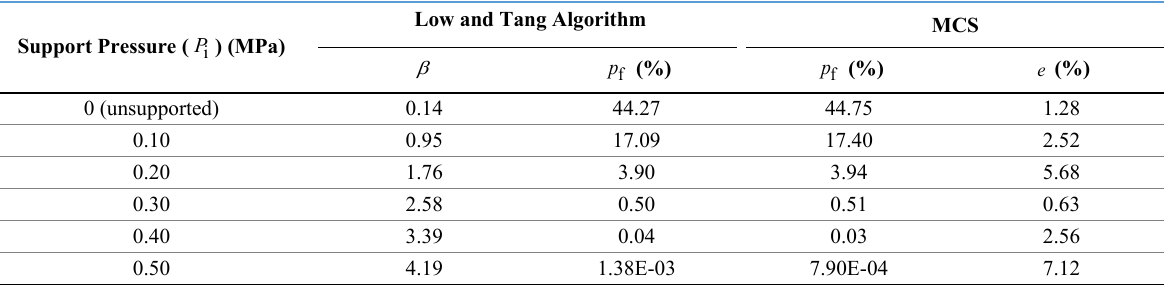
Figure 7. Dispersion results of the plastic zone ( p i / R R ) regarding cohesion ( c ), friction angle ( ϕ ), and far-field stress ( P ∞ ): (a) Tunnel A; (b) Tunnel B. Table 6. Reliability results for the performance function ( ) 1 g x of tunnel A.